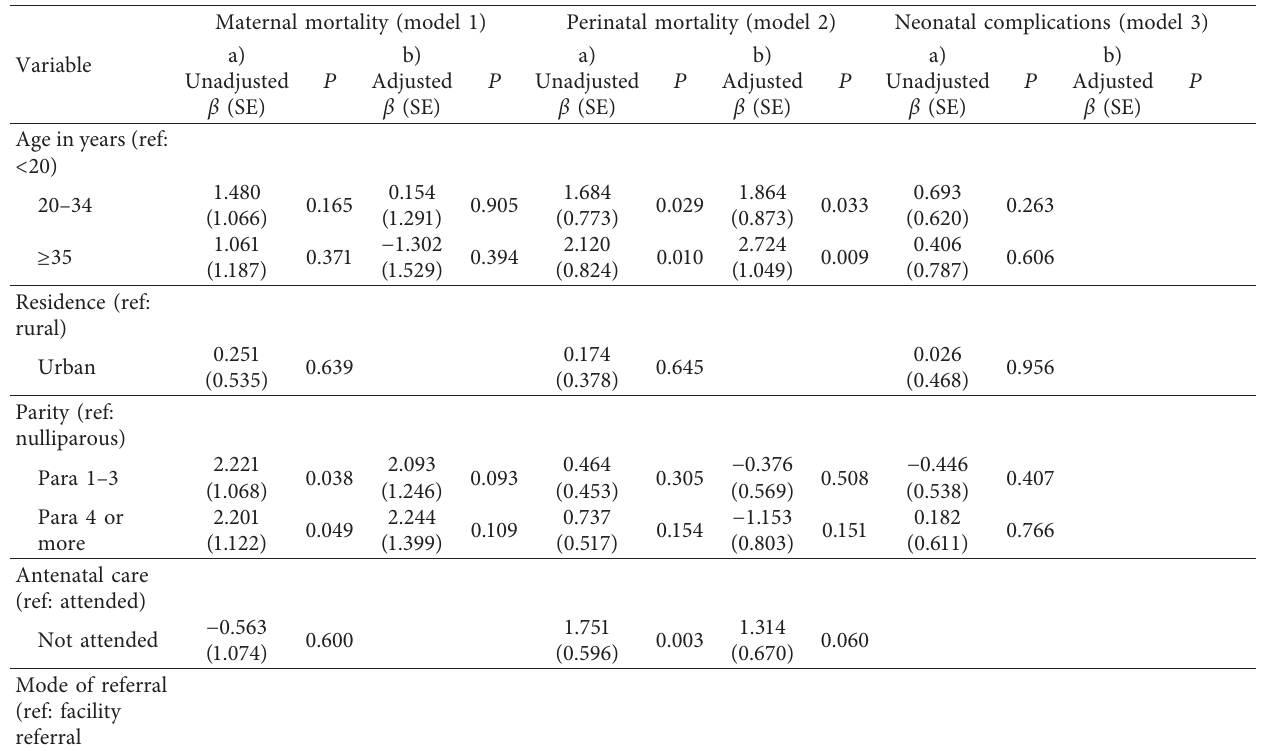
Table 4: Factor associated with maternal and perinatal mortality and neonatal complications, DRRH, Tanzania, January